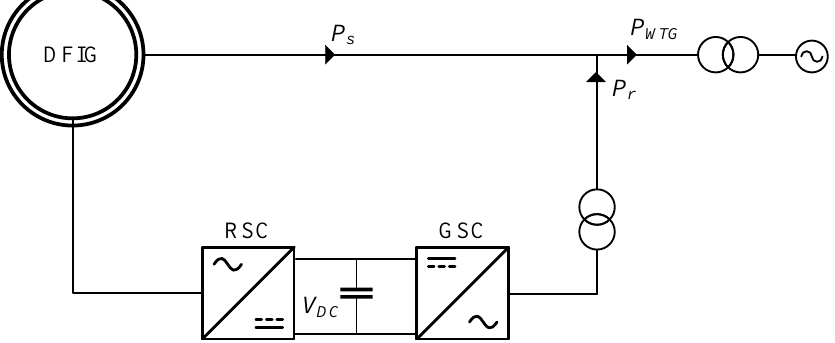
Figure 1. DFIG block diagram, two back-to-back converters connect the rotor to the grid, and the stator is directly connected to the grid.